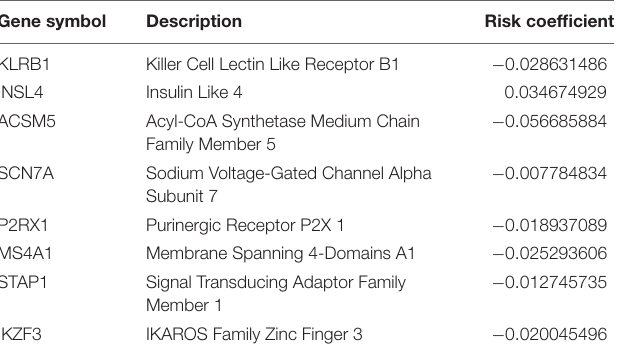
TABLE 2 | Genes in the prognostic gene